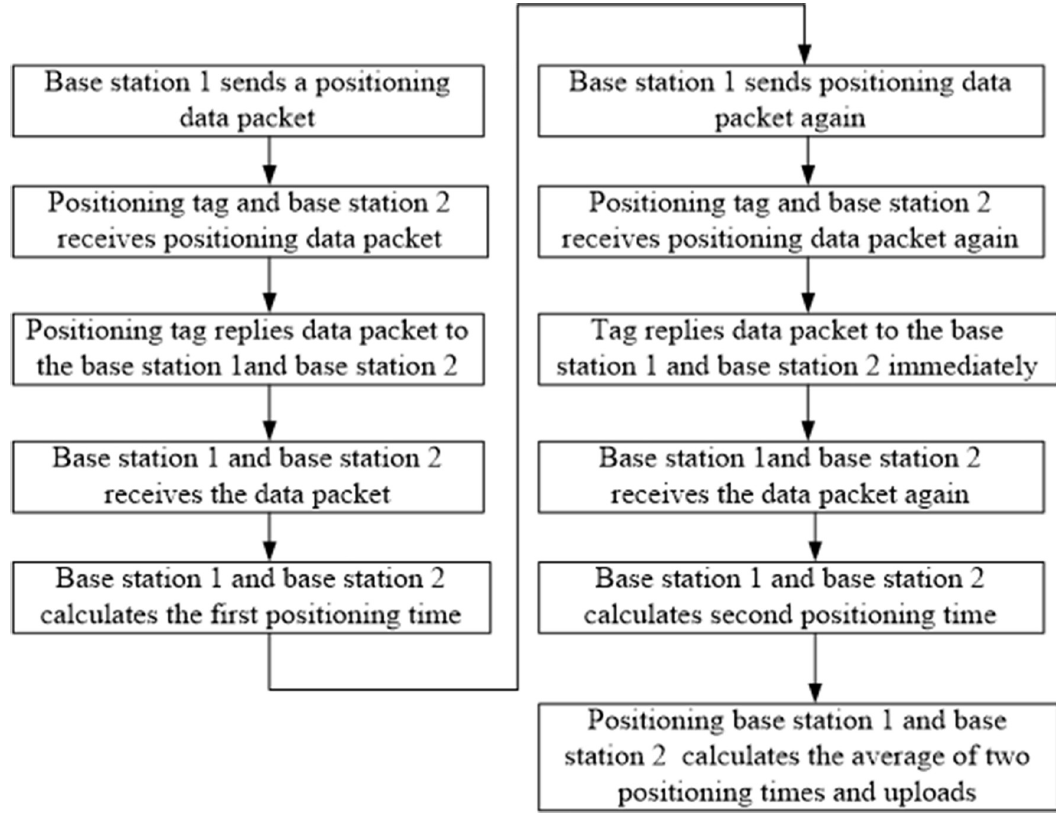
Fig 4. Two-round-trip positioning flow